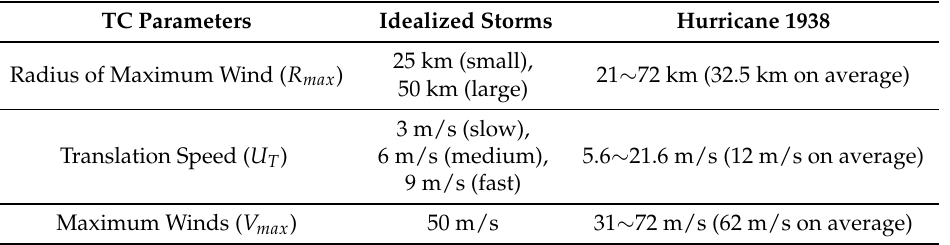
Table 2. Characteristics of idealized storms and Hurricane 1938 between 18 September and 22